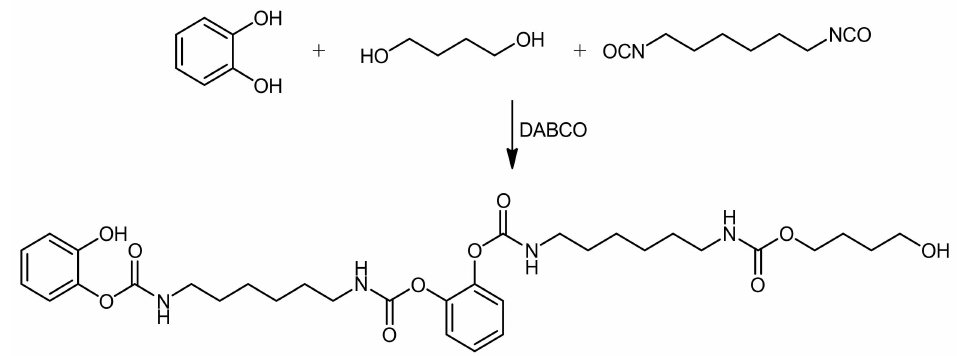
Figure 3. Reaction between 1,2-catechol, 1,4-butanediol, hexamethylene diisocyanate (DABCO as the catalyst).